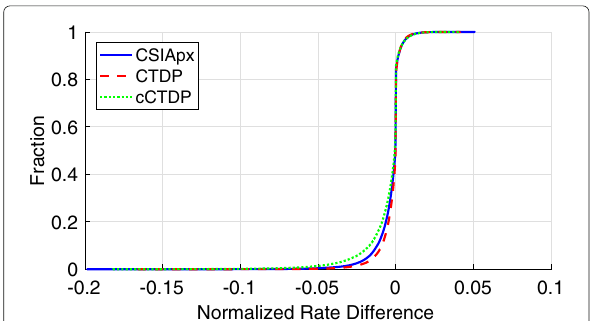
Fig. 7 Normalized rate difference with experimental data. A comparison of the cumulative density function (CDF) of the normalized rate difference is shown when running CSIApx versus CTDP versus